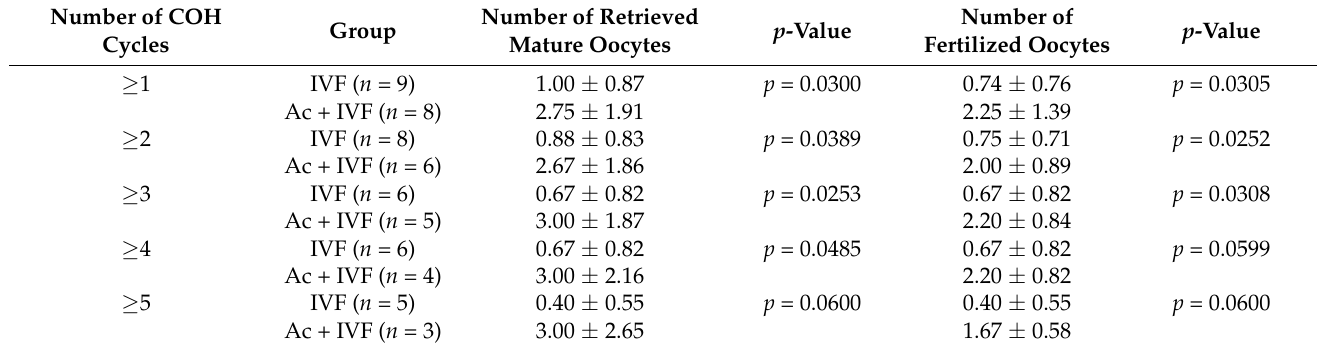
AMH, Anti-Müllerian hormone. Table 9. Comparison of clinical outcomes depending on the number of consecutive IVF cycles in the two study groups. Number of COH